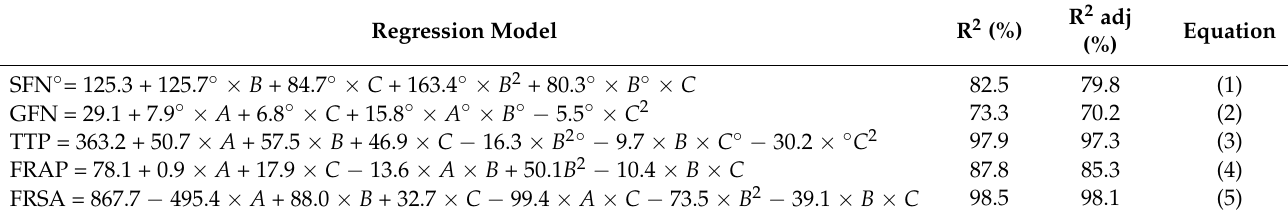
Table 2. Regression models for each response in coded variables. A = solid/liquid ratio; B = ethanol concentration in the extractant solution; C = extraction time. R 2 is the determination coefficient, and R 2 adj is the determination coefficient adjusted by degrees of freedom. SFN is sulforaphane in µ g/g dw, GRA is glucoraphanin in µ g/g dw, TPP is total polyphenols in mg GAE/100 g dw, FRAP is antioxidant activity measured as ferric-ion-reducing ability, and FRSA is antioxidant activity measured as free radical scavenging ability. Models consider only the statistically significant variables.